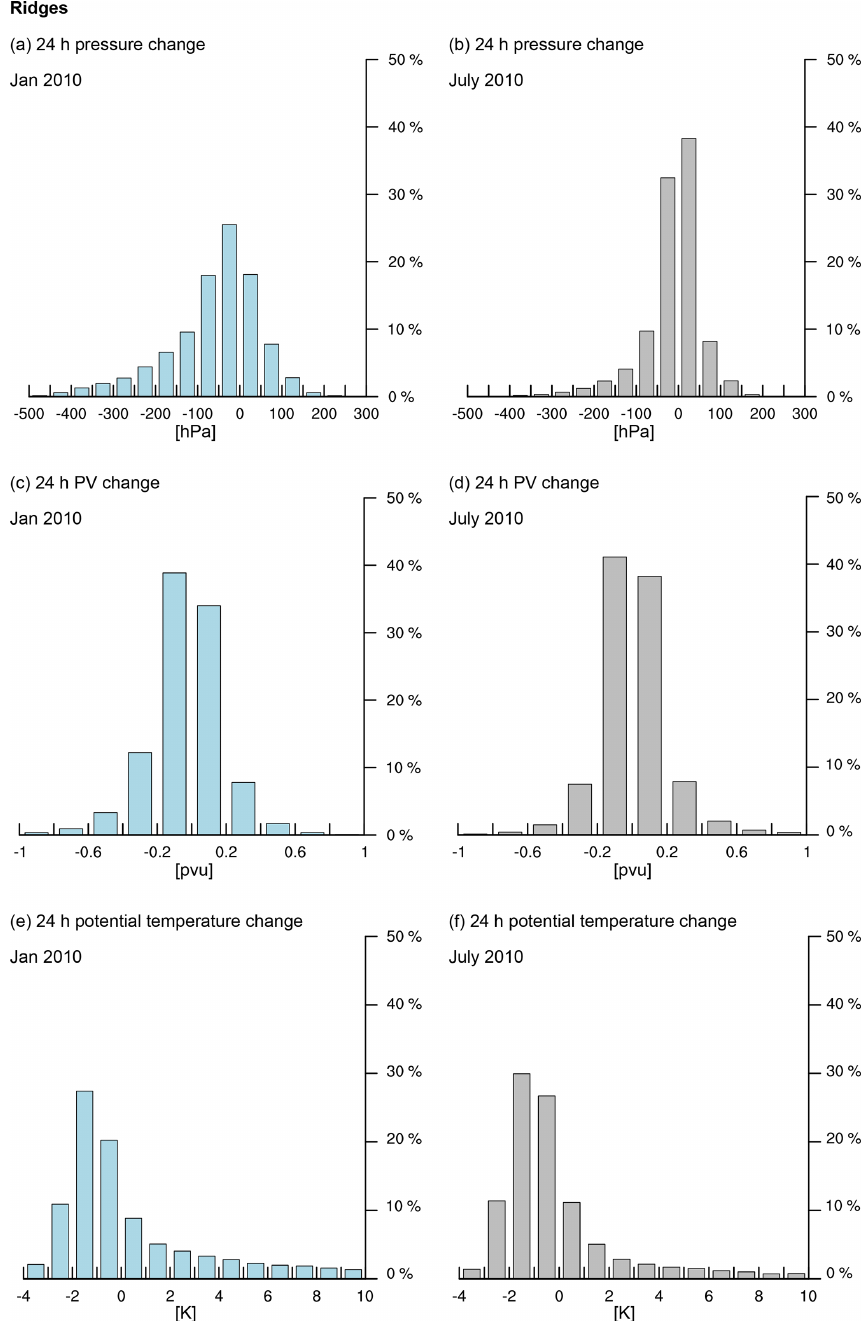
Figure 10. Similar to Fig. 9 but for 500hPa